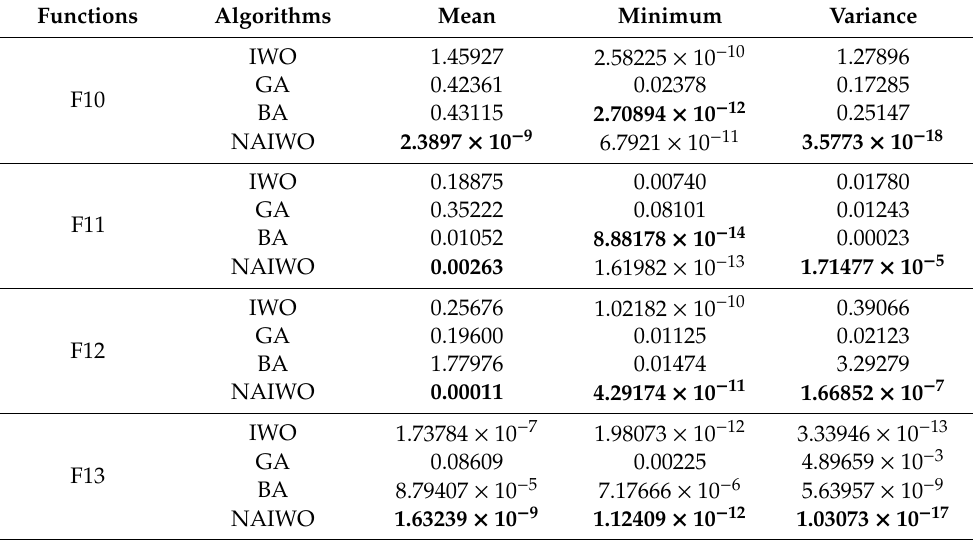
Table A4. Statistical comparison data of IWO, GA, BA, and NAIWO algorithms.